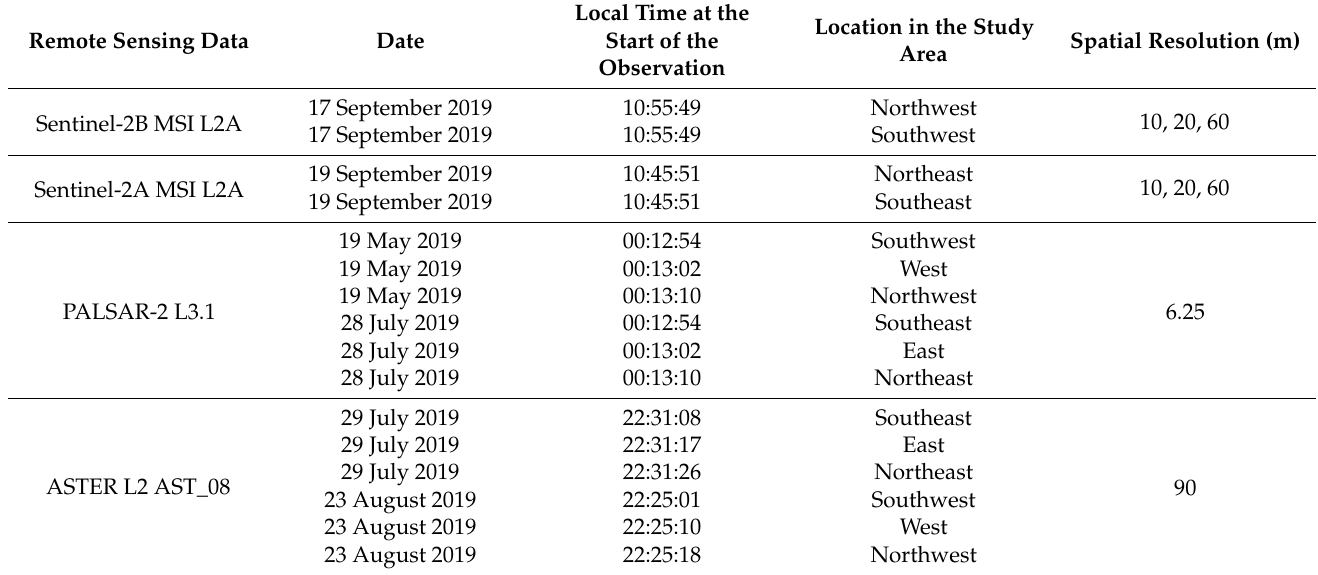
Table 1. Summary of remote-sensing data used in this